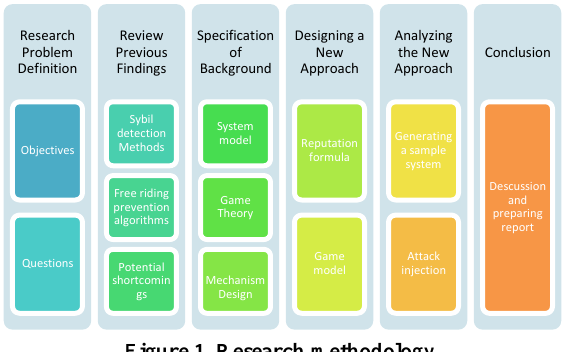
Figure 1. Research